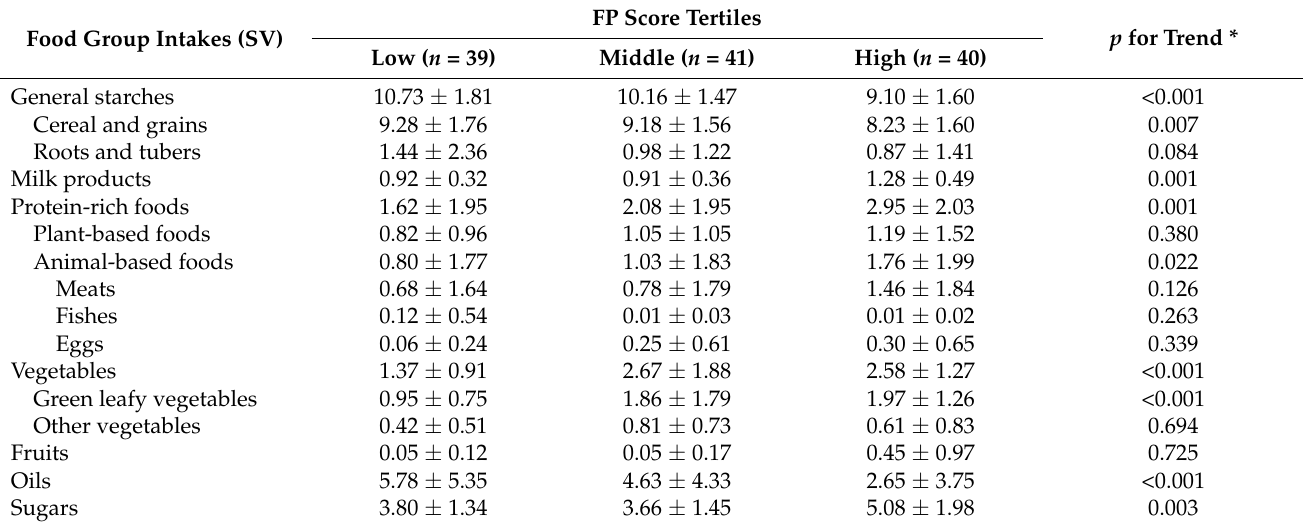
Table 4. Relationship between the food group SV counts and FP score tertiles.